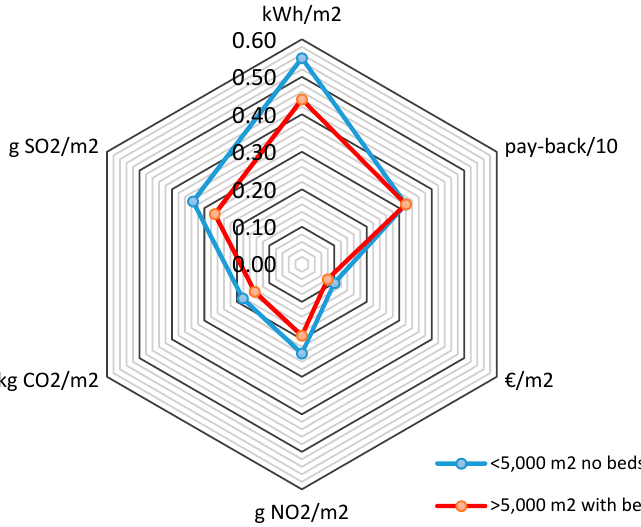
Figure 1. Potential energy saving derived from optimizing the electric energy installations.